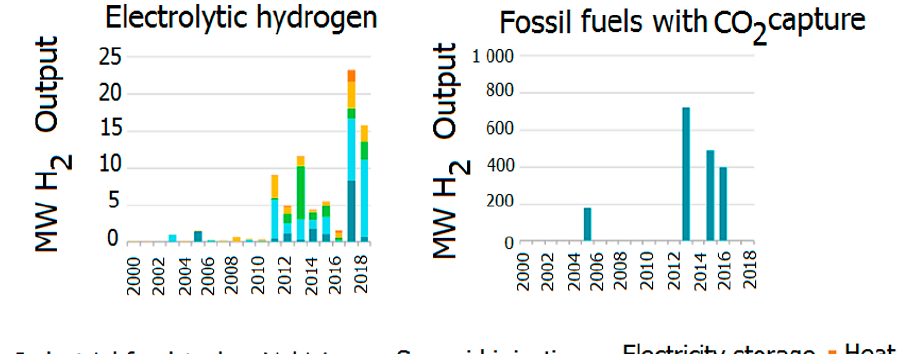
Figure 1. Hydrogen production capacity by technology and start date [7].